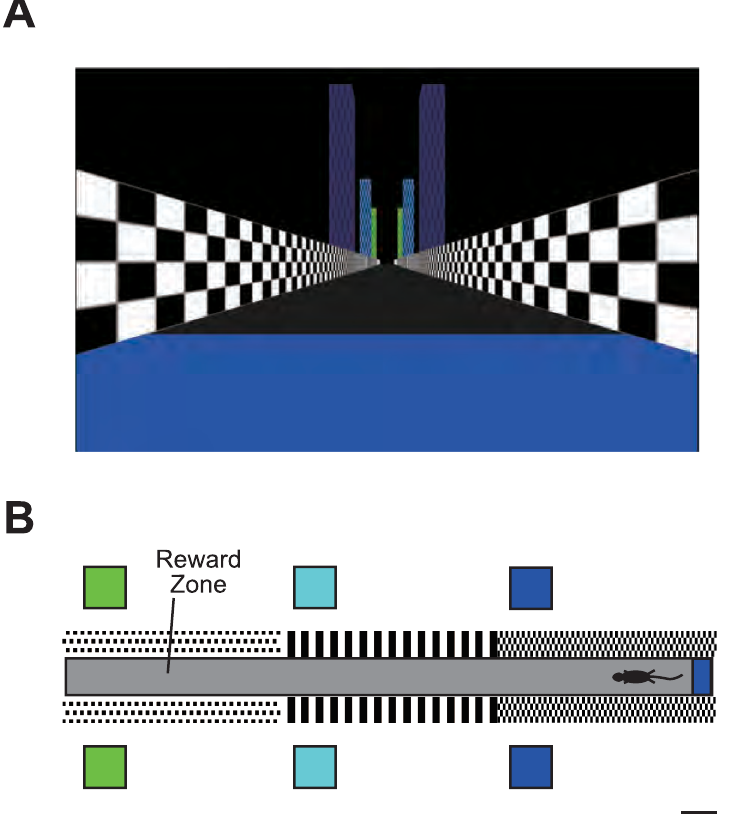
Fig 2. VR systemfor mice. (A) View from start point of the virtual linear track. (B) Top view of the track. Scale bar, 10